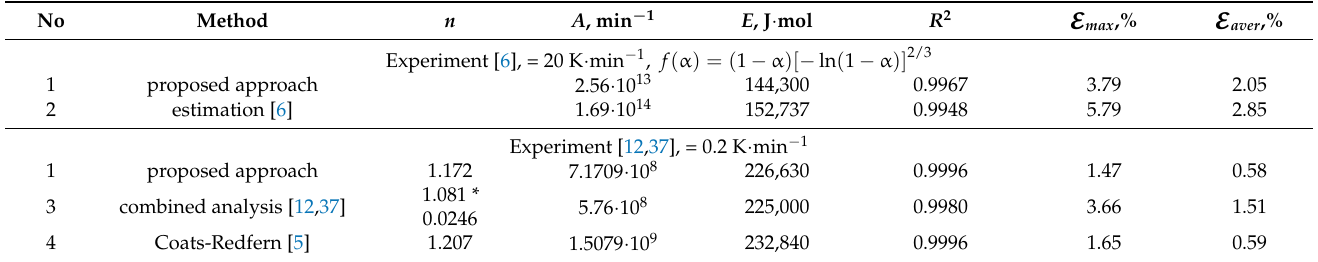
Table 4. Percentage accuracy of various kinetic triplets for the model Equation (5). Table 3. Percentage error ℰ in determining the activation energy 𝐸 . Table 3. Percentage error ℰ in determining the activation energy 𝐸 Reaction